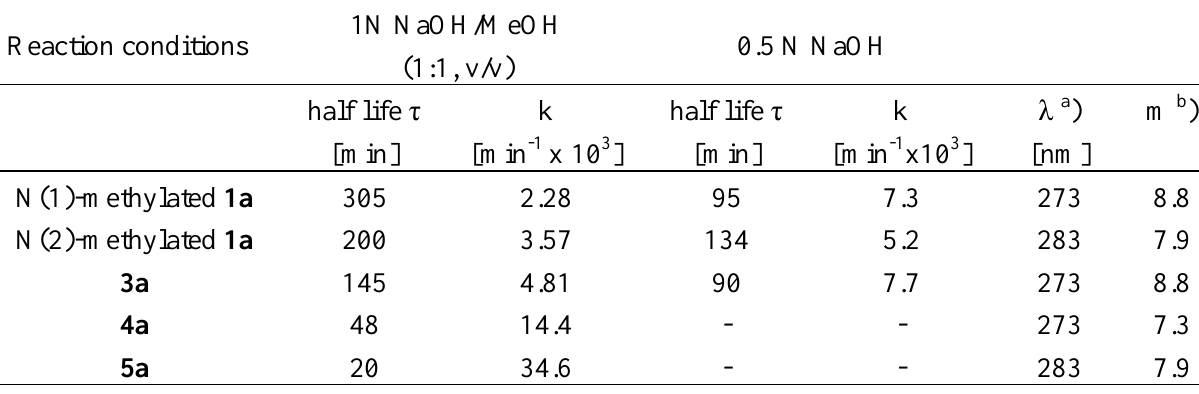
group displacement 3